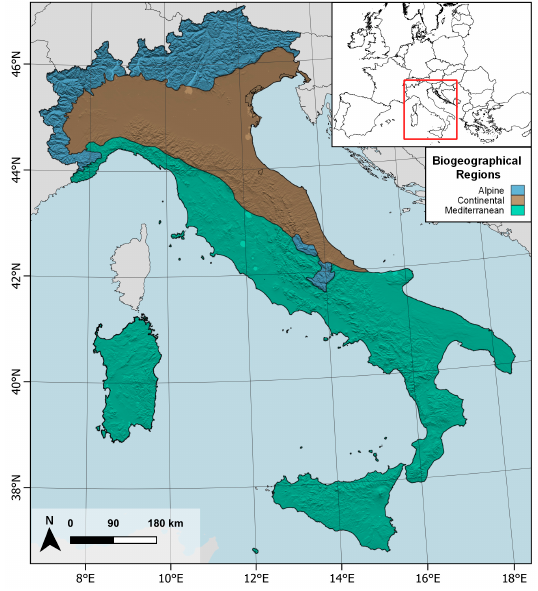
Figure 2 . Overview of the Italian territory at continental scale and the distribution of European biogeographical regions (adapted from [65]). Table 1. The forest types present in Italy according to the National Forest Inventory of 2005 1 and the European Atlas of Forest Tree Species 2 .